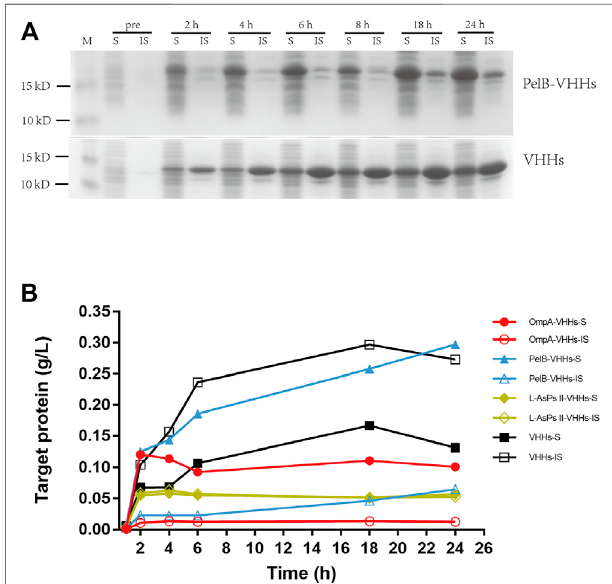
FIGURE 1 | The expression of anti-green fl uorescent protein (GFP) variable domains of the H chain of heavy-chain antibodies (VHHs) with differentsignalpeptides(SPs)inisopropyl β -D-thiogalactoside(IPTG)-induced E. coli BL21 (DE3). (A) sodium dodecyl sulfate – polyacrylamide gel electrophoresis(SDS-PAGE)ofVHHswithPelB(upperpanel)andVHHsalone (lower panel). (B) The time-dependent expression level of VHHs alone (black) and VHHs with OmpA (red), PelB (blue), and L-AsPs II-SP (yellow). S, soluble fraction; IS, insoluble fraction. Concentration of IPTG: 0.02 mM.